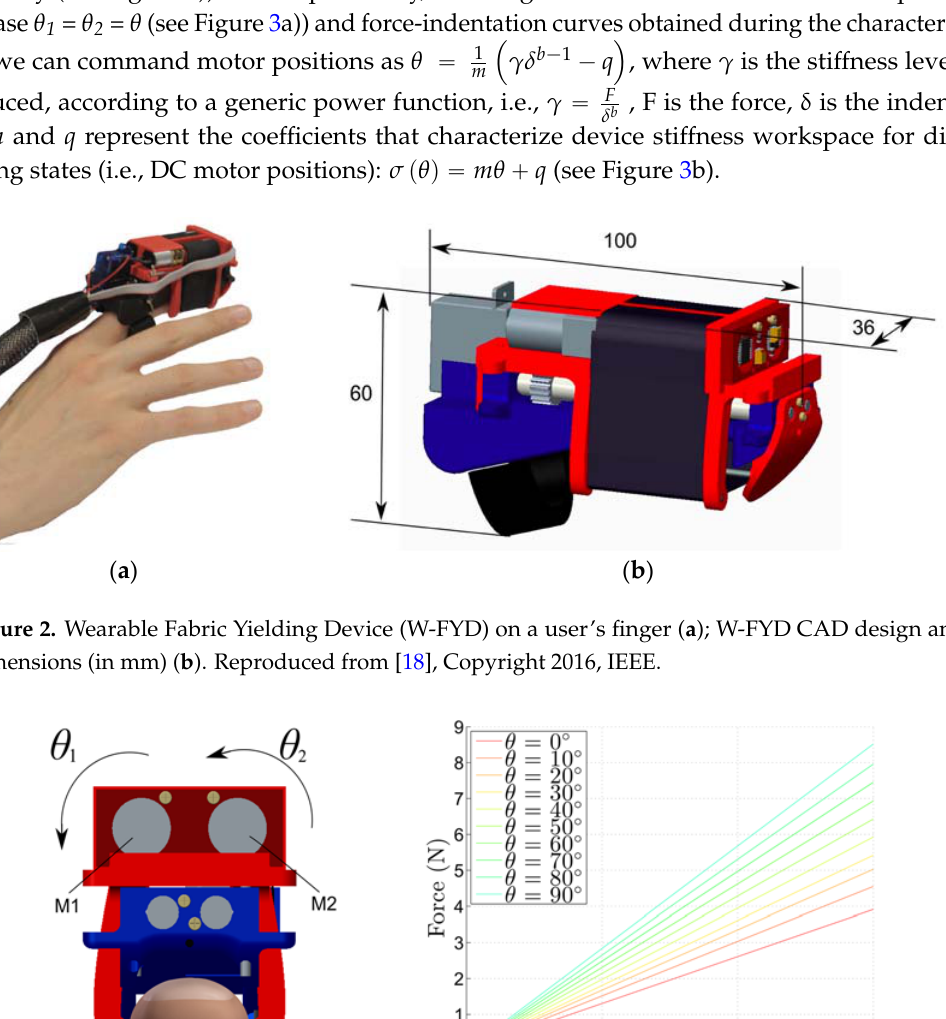
Figure 3. Representation of a finger interacting with the W ‐ FYD ( a ); characterization curves for different motor positions ( θ 1 and θ 2 ) ( b ). Reproduced from [18], Copyright 2016, IEEE.